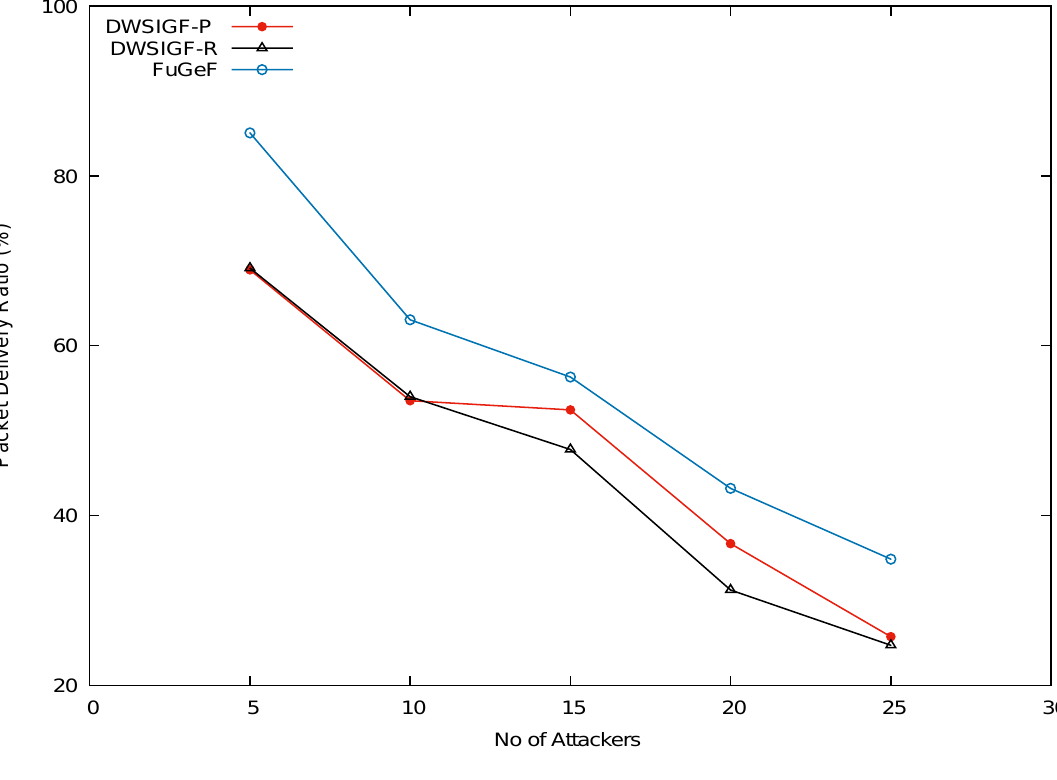
Figure 8. Packet